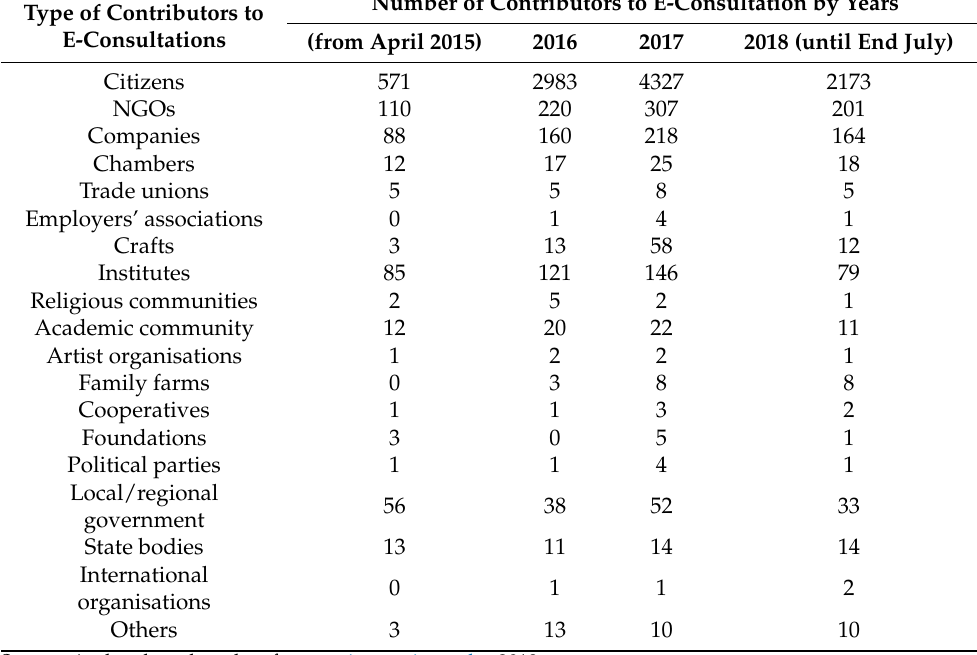
Table 3. Overview of types of contributors to online public consultations via the central government